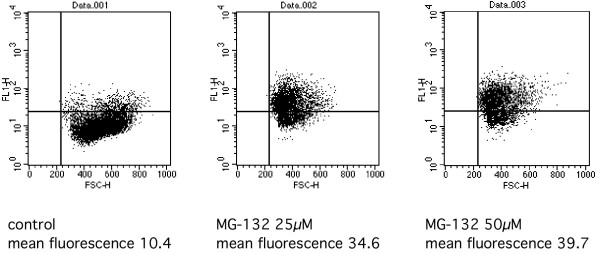
MG-132 induces apoptosis in PC-3 cells. Representative (n = 3) FACS analysis of PC-3 prostate cancer cells incubated with 0, 25 and 50 μM concentrations of MG-132 for 24 h. TUNEL-staining indicated an increase of apoptotic cells from 7.6 % in control cells to 66.5 % and 72.8 % in MG-132 treated cells.